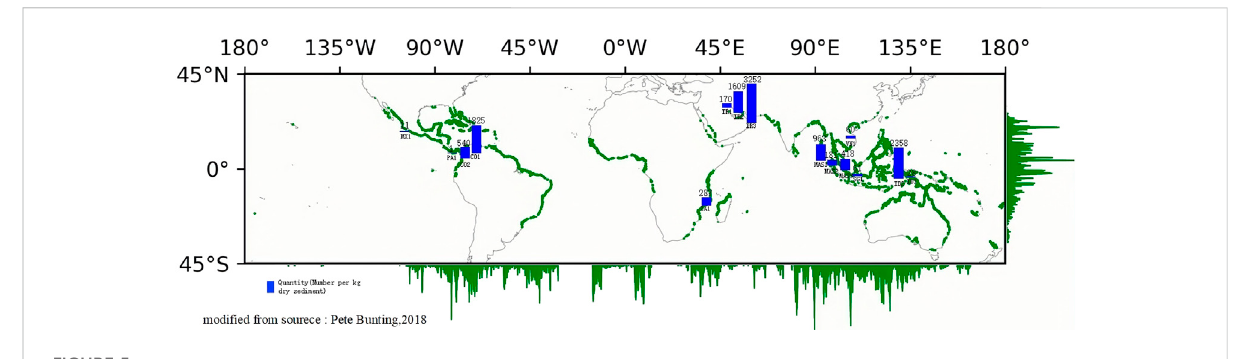
FIGURE 5 Distribution of microplastic pollution in mangrove wetlands